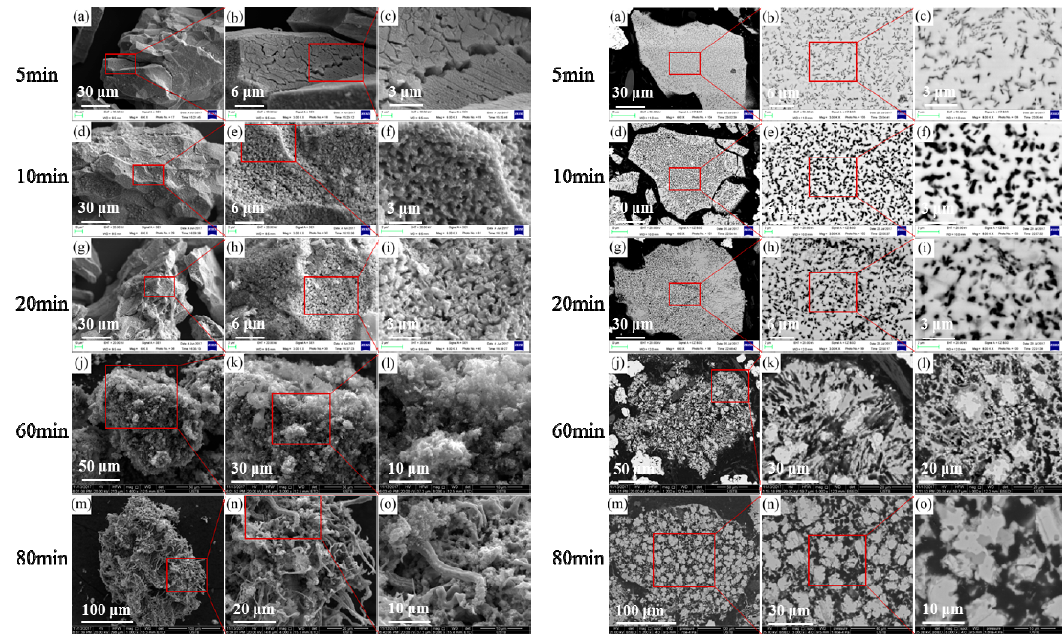
Figure 8. Microscopic observation of the particle surface morphology (left column) and the cross-section morphology (right column) of the iron ore particles after reduction at 973 K in 95% CO + 5% CO 2 atmosphere.